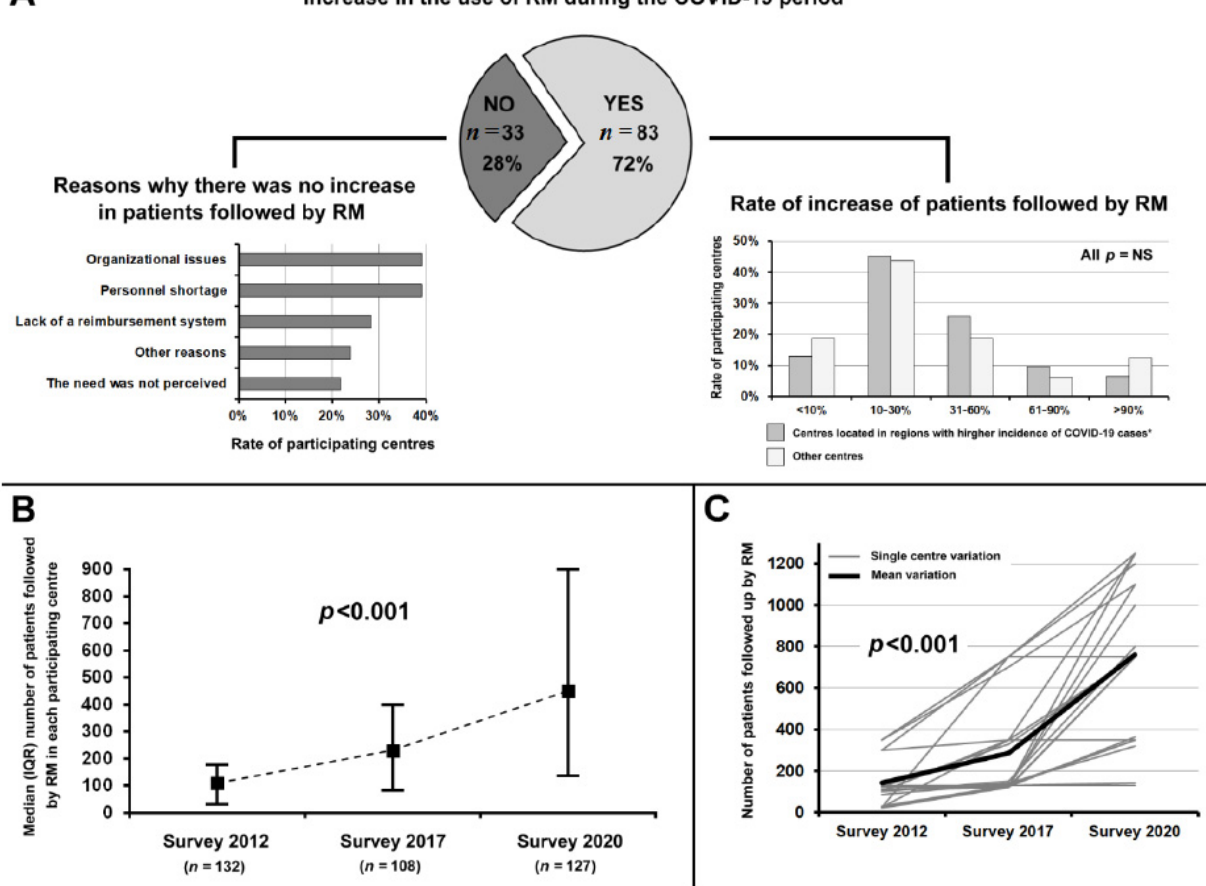
Figure 3. ( A ) Rate of participating centres reporting or not an increase in the use of remote monitoring during the COVID-19 pandemic; reasons why there was no increase in the number of patients followed up by remote monitoring (graph on the right); rate of increase in patients followed up by remote monitoring (graph on the left). ( B ) Median number of patients per centre followed up by remote monitoring in 2012, 2017 and 2020 surveys. ( C ) Variation in the number of patients followed up by remote monitoring from 2012, 2017 and 2020 in the centres which participated in all three surveys. * Data from Italian Civil Protection Department [2]. IQR, interquartile range; NS, not significant; RM, remote monitoring.